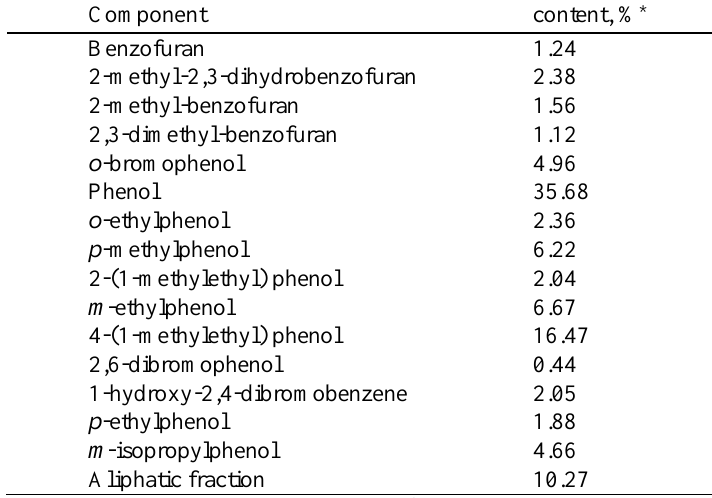
Table 1. Composition of the main component of oil resulting from the pyrolysis of